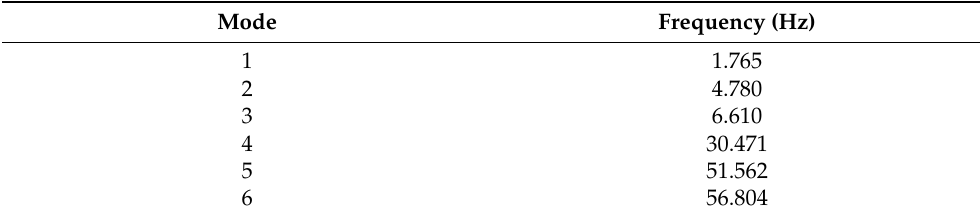
Table 1. Six first natural frequencies found according to FEM simulation.